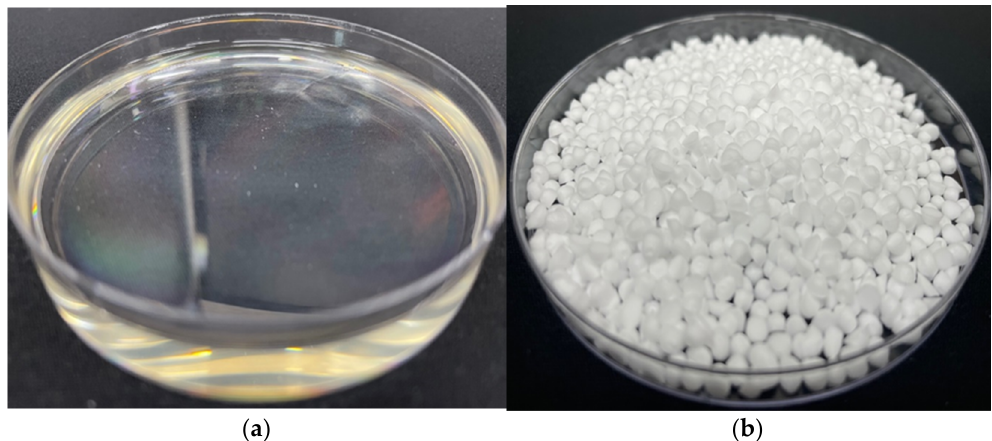
Figure 2. Pure materials at room temperature (25 °C): ( a ) caprylic acid, ( b ) stearyl alcohol.